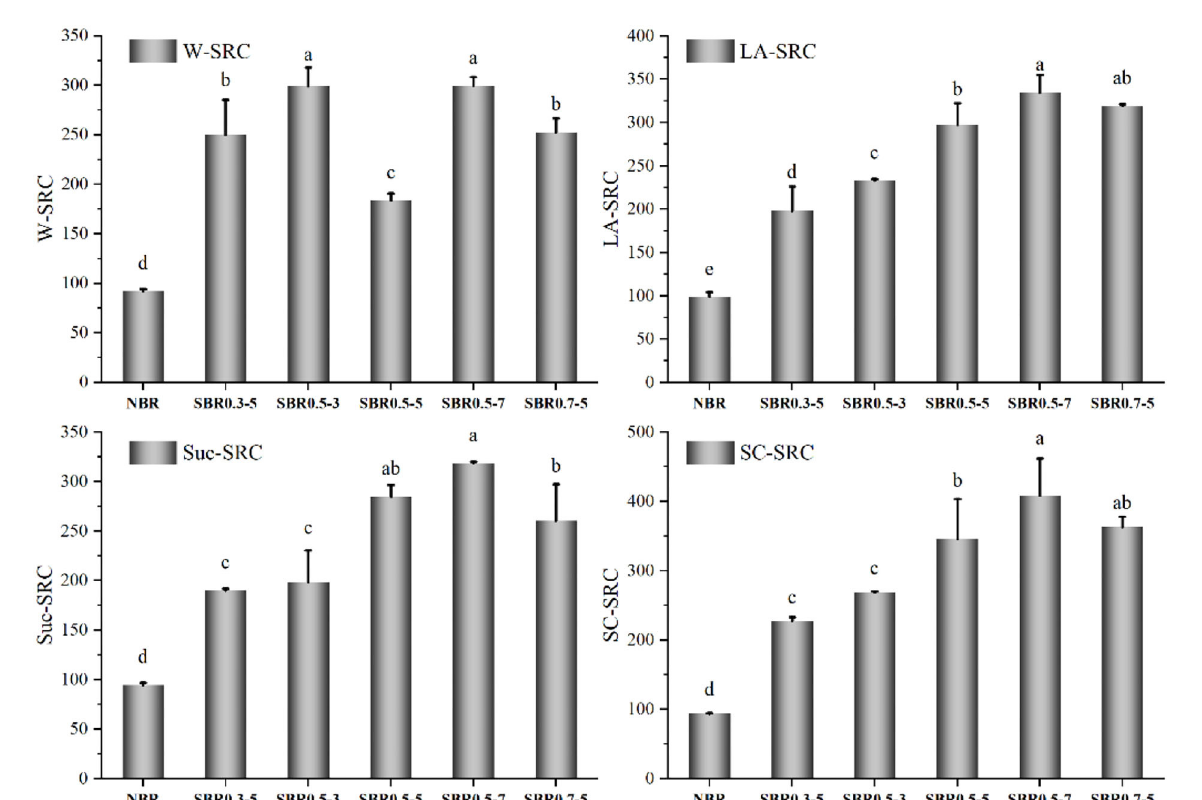
FIGURE4 Effect of steam explosion on the solvent retention capacity (SRC) values of brown rice powder. Suc-SRC, sucrose SRC; SC-SRC, sodium carbonate SRC; LA-SRC, lactic acid SRC; W-SRC, water SRC; NBR, native brown rice powder; SBR, steam exploded brown rice powder; SBR0.3-5, SBR at 0.3 MPa for 5min; SBR0.5-3, SBR at 0.5 MPa for 3min; SBR0.5-5, SBR at 0.5 MPa for 5min; SBR0.5-7, SBR at 0.5 MPa for 7min; SBR0.7-5, SBR at 0.7 MPa for 5min (Means that do not share a letter are significantly different, p < 0.05).